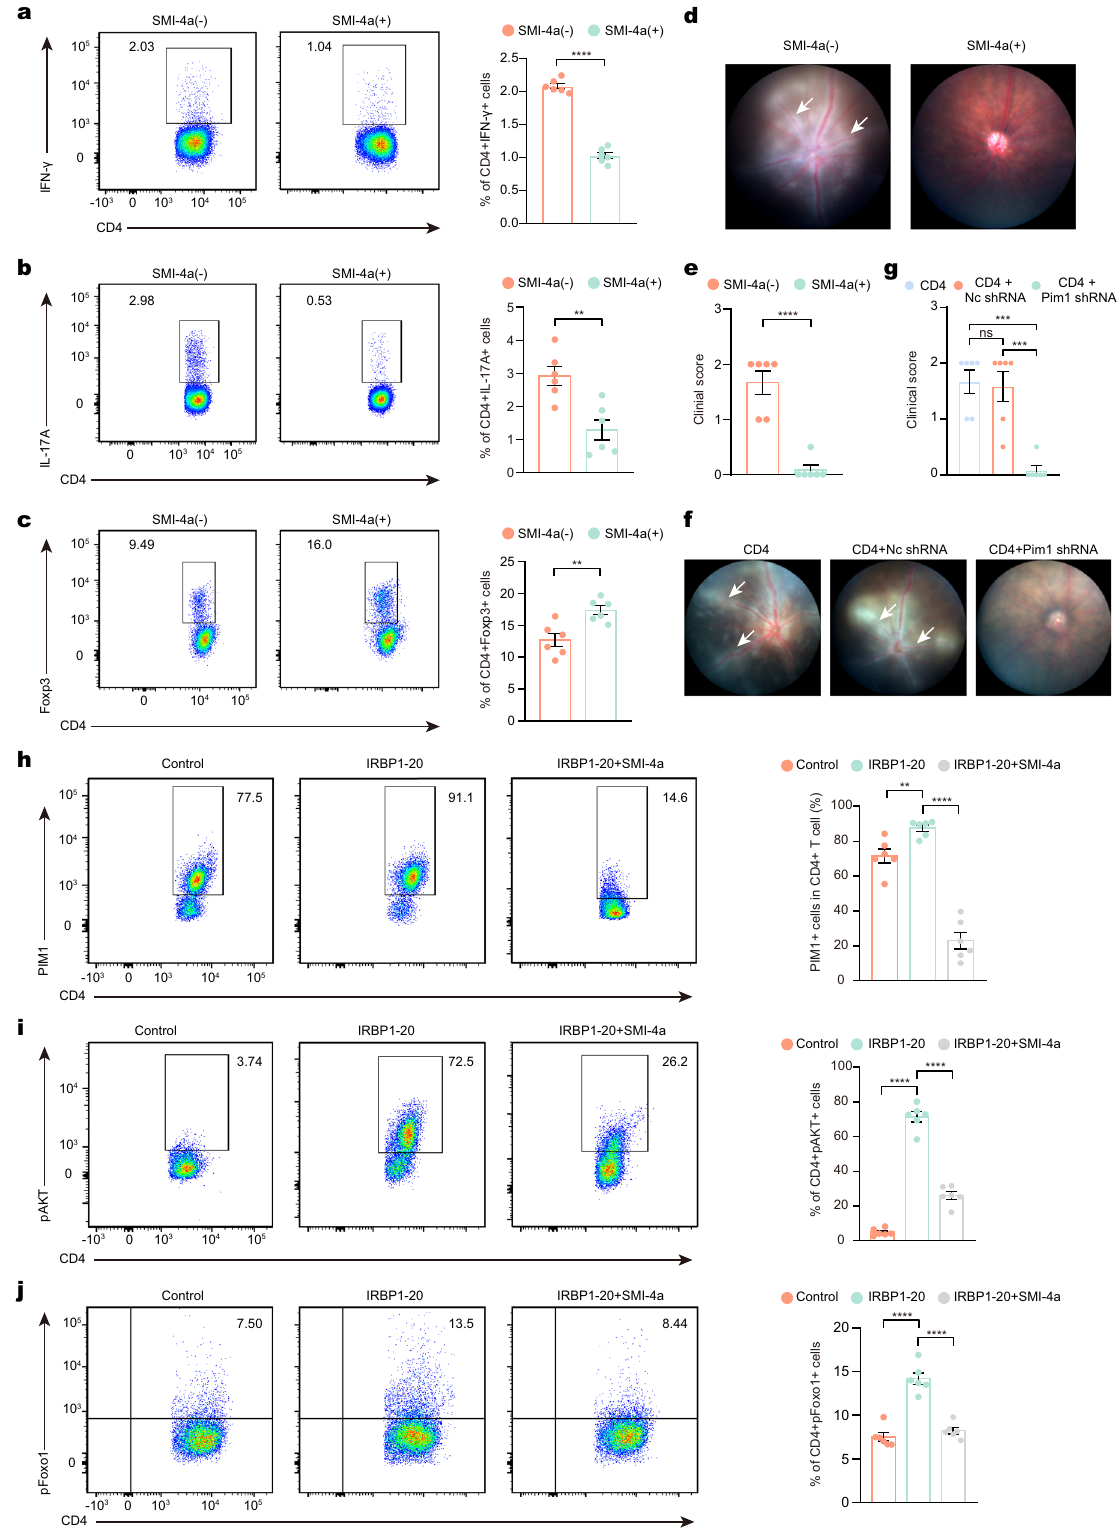
function and generation of Treg cells 29 . Phosphorylation of FOXO1 causes it to re-localize to the cytosol and lose its function 29 . In our experiments, CD4 + T cells from EAU mice exhibited increased PIM1 expression as well as phosphorylation of AKT and FOXO1 in response to autoantigen challenge, whereas inhibition of PIM1 reversed these changes. Thus, aberrant PIM1/AKT/FOXO1 signaling may mediate